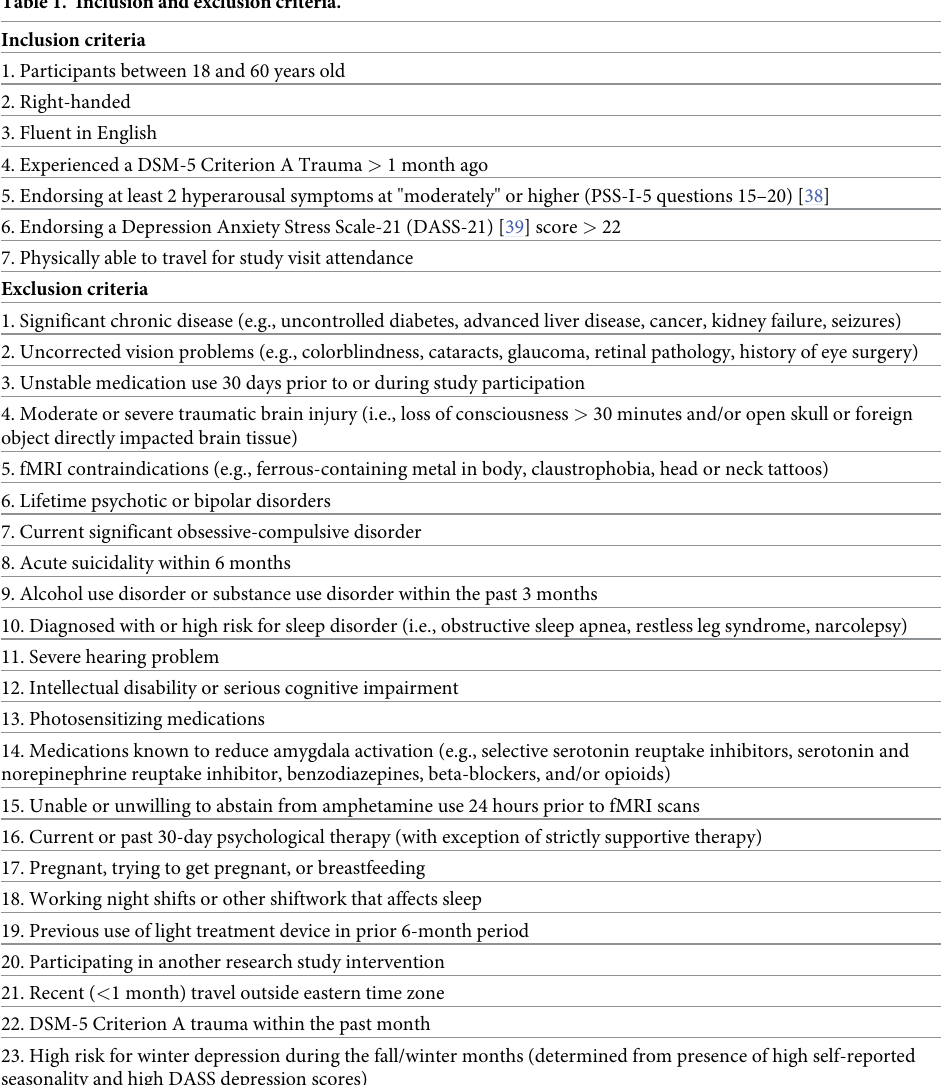
Table 1. Inclusion and exclusion